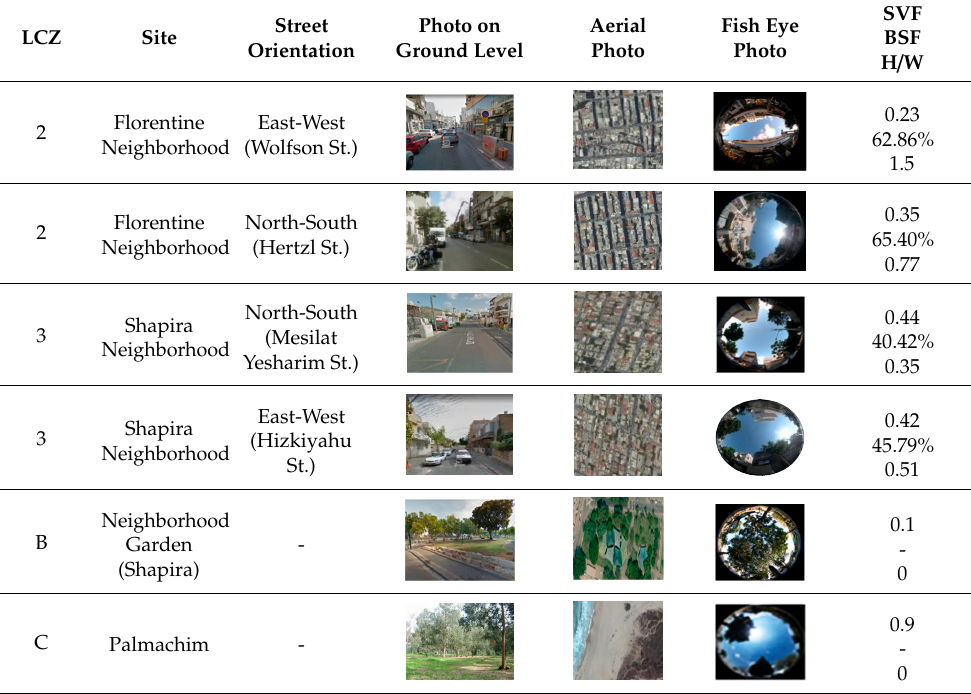
Table 3. Values of geometric and surface cover properties for local climate zones of Tel Aviv. LCZ